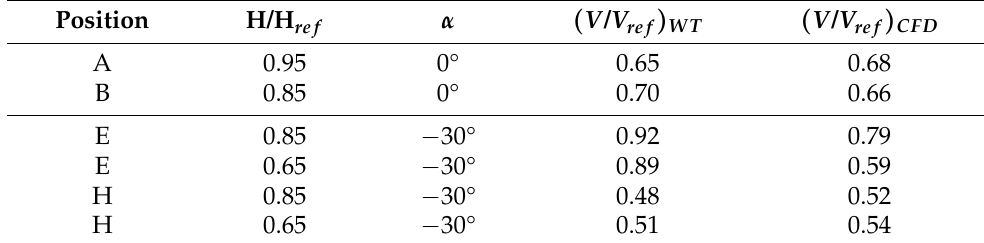
Table 5. Velocity measures: WT vs.